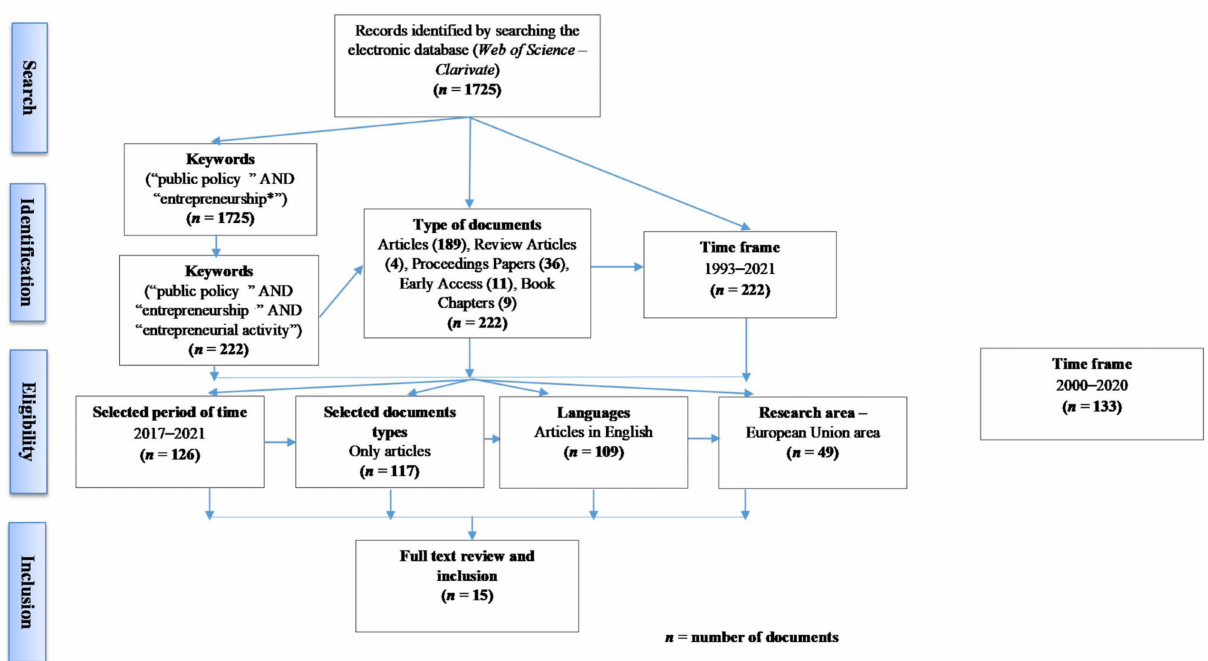
Figure 1. The systematic selection strategy of the studies highlights the relationship between public policy, entrepreneurship, and entrepreneurial activity. Source: authors’ own